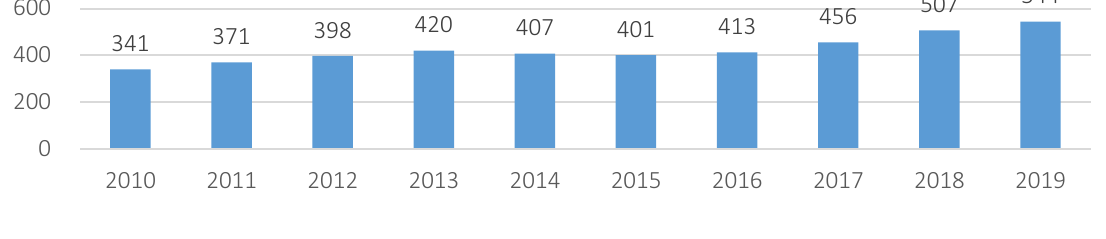
Figure 1. Thailand’s GDP per year from 2010 to 2019